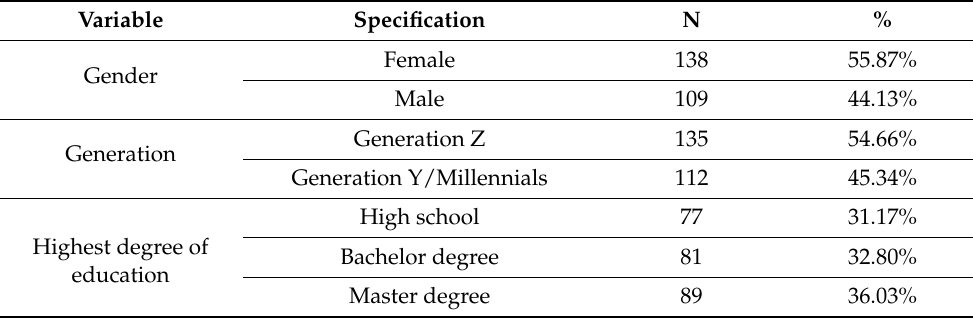
Table 1. Sample structure.